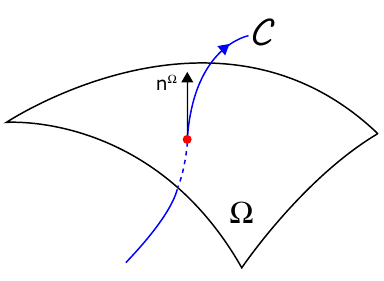
Figure 2 . Wilson line along C piercing a surface (cid:10). The normal on the surface n (cid:10) and the orientation of the curve C determine whether the (cid:18) -function evaluates to +1 or (cid:0)